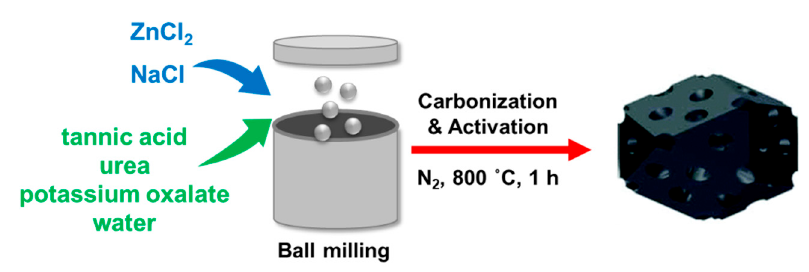
Figure 5. Scheme illustrating the synthesis of tannic acid-derived activated